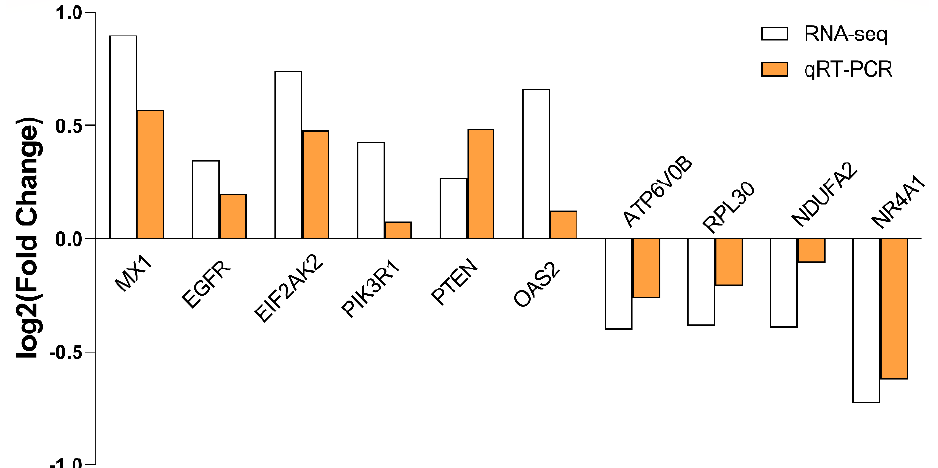
Figure 11. The verification of RNA-Seq results by qRT-PCR, between E. coli and E. coli +pBD2 groups. The samples were analyzed in triplicate by qRT-PCR, and fold-changes in gene expression were calculated by 2 − ∆∆ CT methods with TUBA1B (tubulin alpha 1b) as a reference gene. MX1: Interferon-induced GTP-binding protein Mx1; EGFR: Epidermal growth factor receptor; EIF2AK2: Eukaryotic translation initiation factor 2 alpha kinase 2; PIK3R1: Phosphoinositide-3-kinase regulatory subunit alpha; PTEN: Phosphatidylinositol 3,4,5-trisphosphate 3-phosphatase; OAS2: 2’-5’-oligoadenylate synthetase 2; ATP6V0B: ATPase H+ transporting V0 subunit b; RPL30: Ribosomal protein L30; NDUFA2: NADH dehydrogenase [ubiquinone] 1 alpha subcomplex subunit 2; NR4A1: Nuclear receptor subfamily 4, group A, member 1.